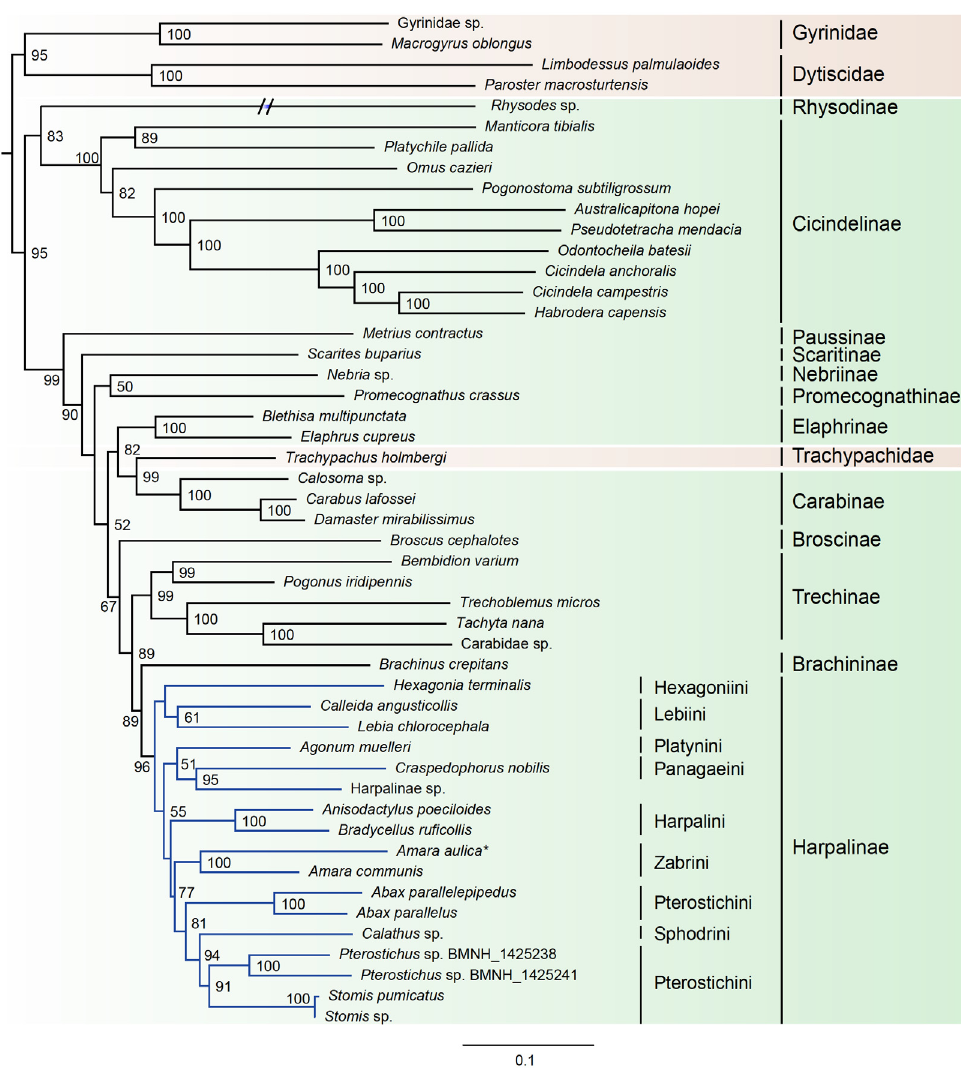
Figure 2. Maximum likelihood tree inferred from the dataset of 49taxa_PCGRNA using IQ-TREE, under the partition schemes and best-fitting models selected by PartitionFinder. Bootstrap support values ( ≥ 50) are indicated near the nodes. The branch of Rhysodes is depicted as half of its original branch length. Green background indicates the ingroup taxa of Carabidae, and brown indicates the outgroups. Blue lines indicate the Harpalinae. The newly determined Amara aulica is emphasized by asterisk.